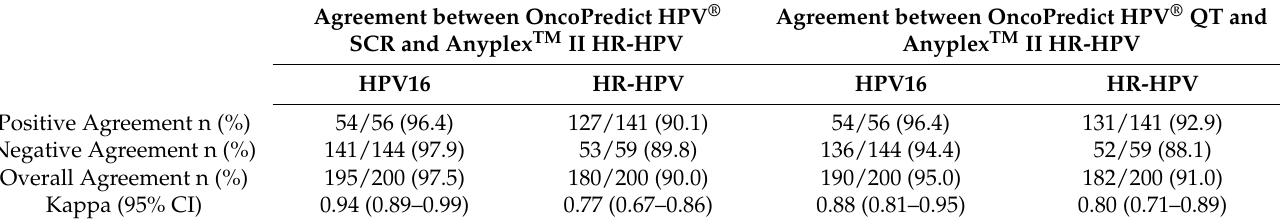
Table 1. Analytical agreement in HR-HPV and HPV16 detection between OncoPredict HPV ® SCR and QT assays and Anyplex™ II HR-HPV.